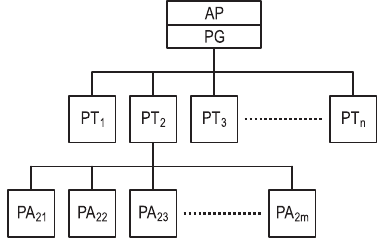
Fig 1. Structural elements of an action plan